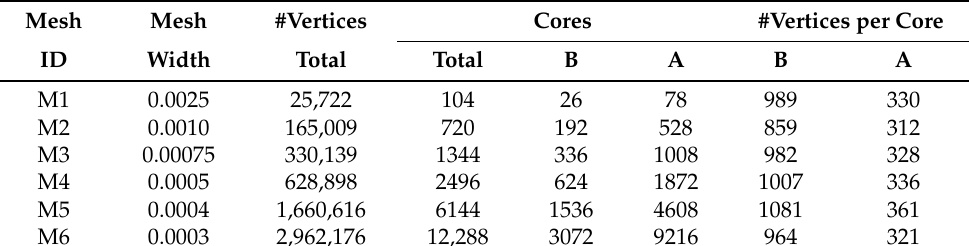
Table 3. Weak scalability measurements: Meshes for the wind turbine blade at varying mesh resolution (mesh width). The mesh width indicates the average edge length used to construct the surface mesh. The total number of cores is approximately proportional to the number of mesh vertices. The available CPU cores are distributed with a 1:3 ratio between the solvers.